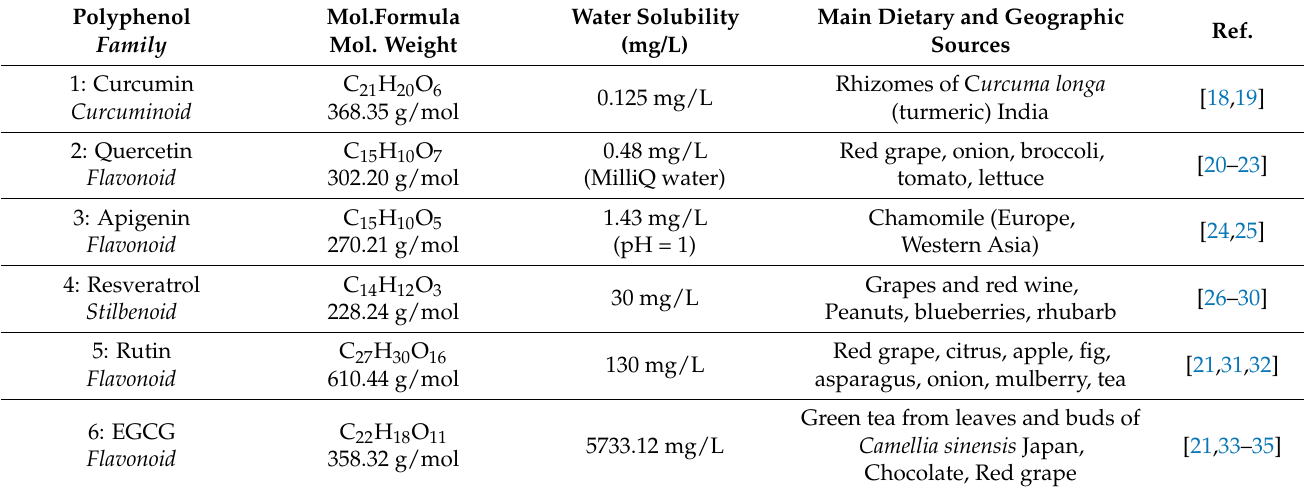
Table 3. Main characteristics of selected